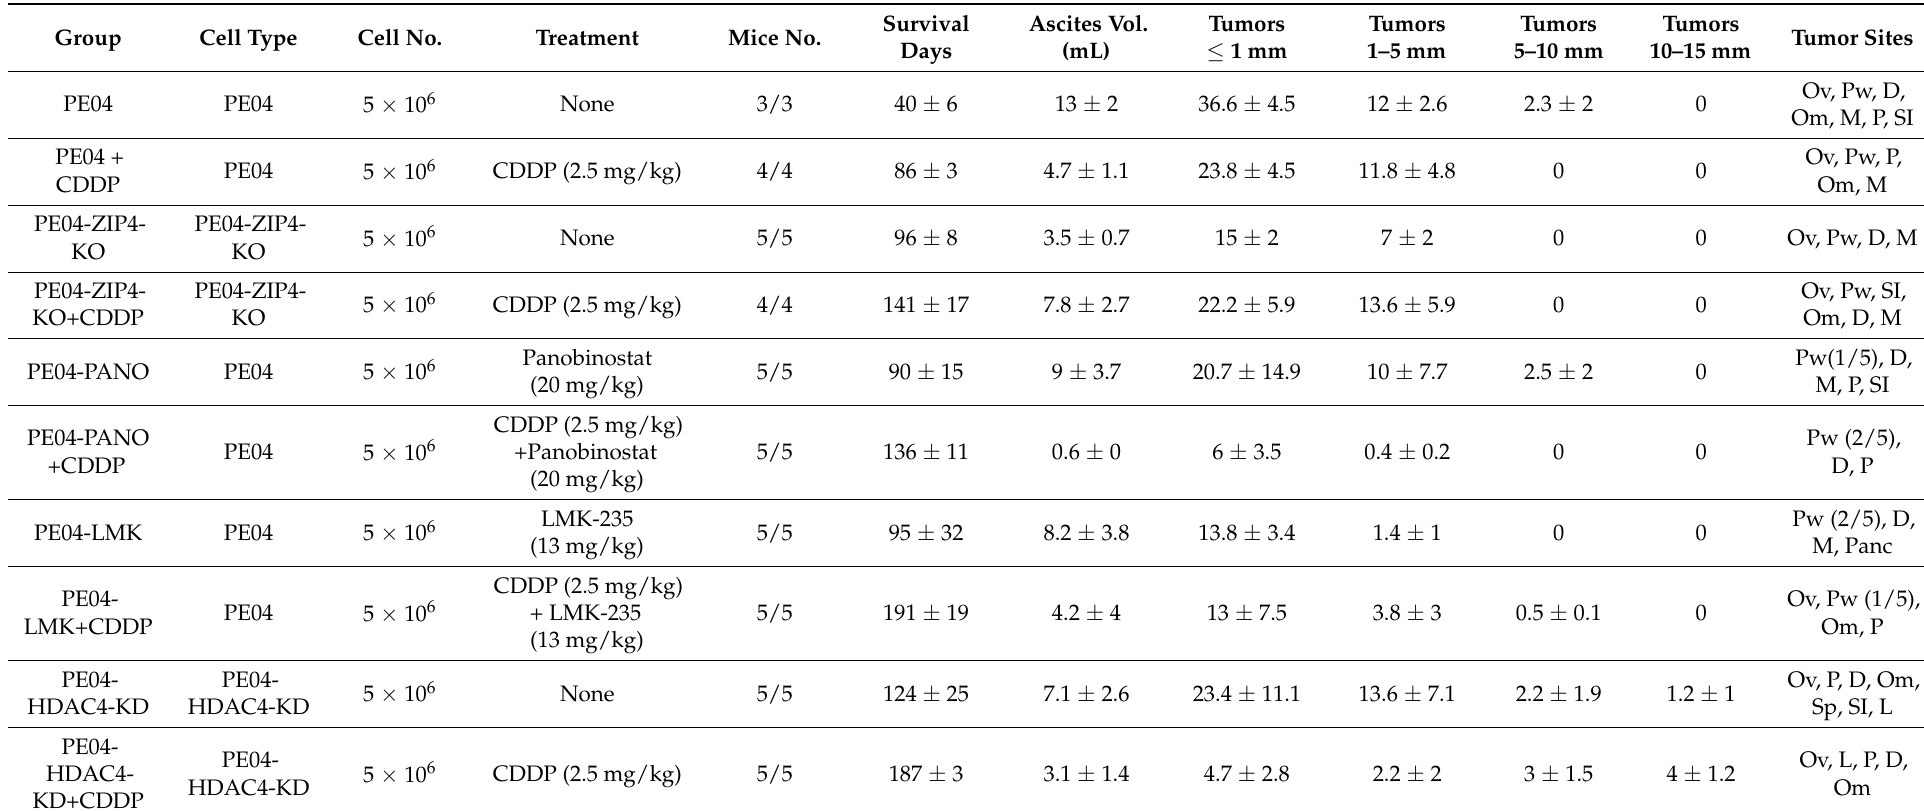
Table 1. Summary of tumor and ascites formation in different mouse